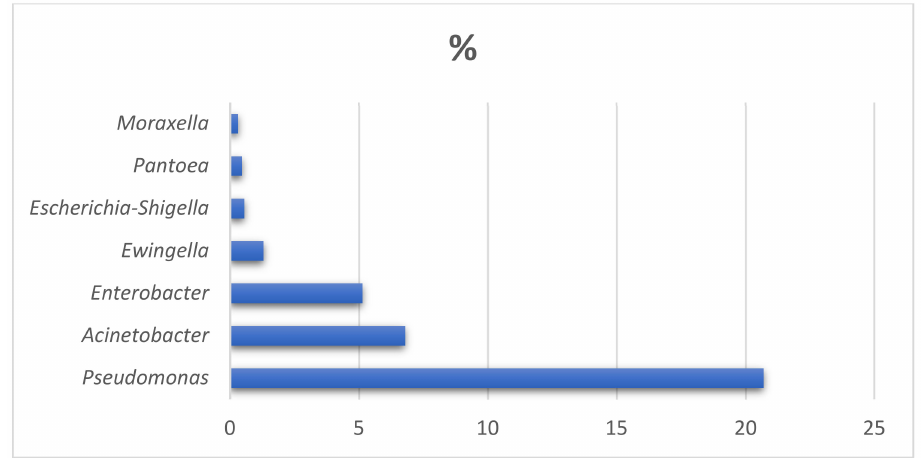
Figure 4. Gram-negative genera detected in Slovak ewe’s lump cheese (in